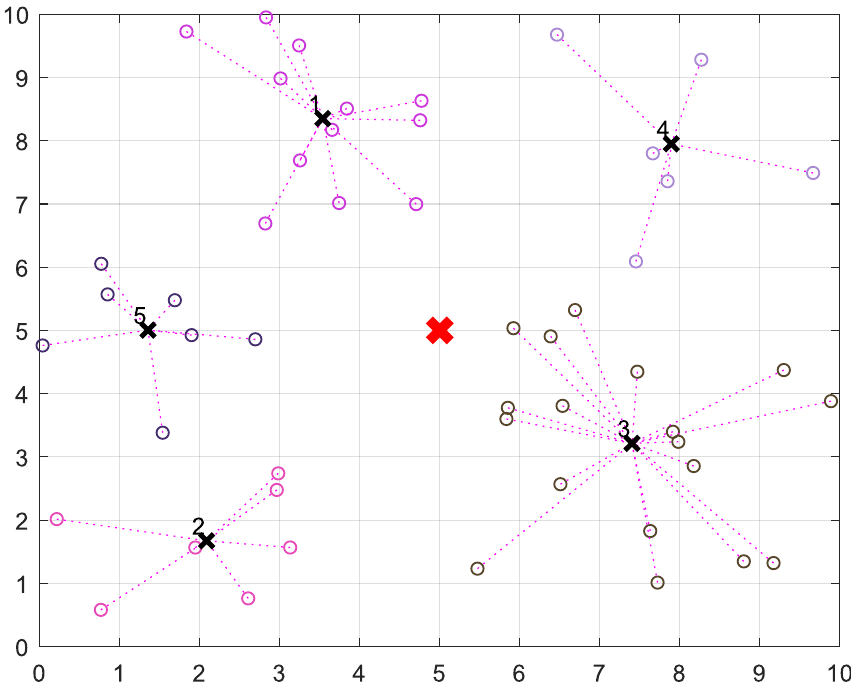
Table 11. Travel distances (km) from the cluster centroids.